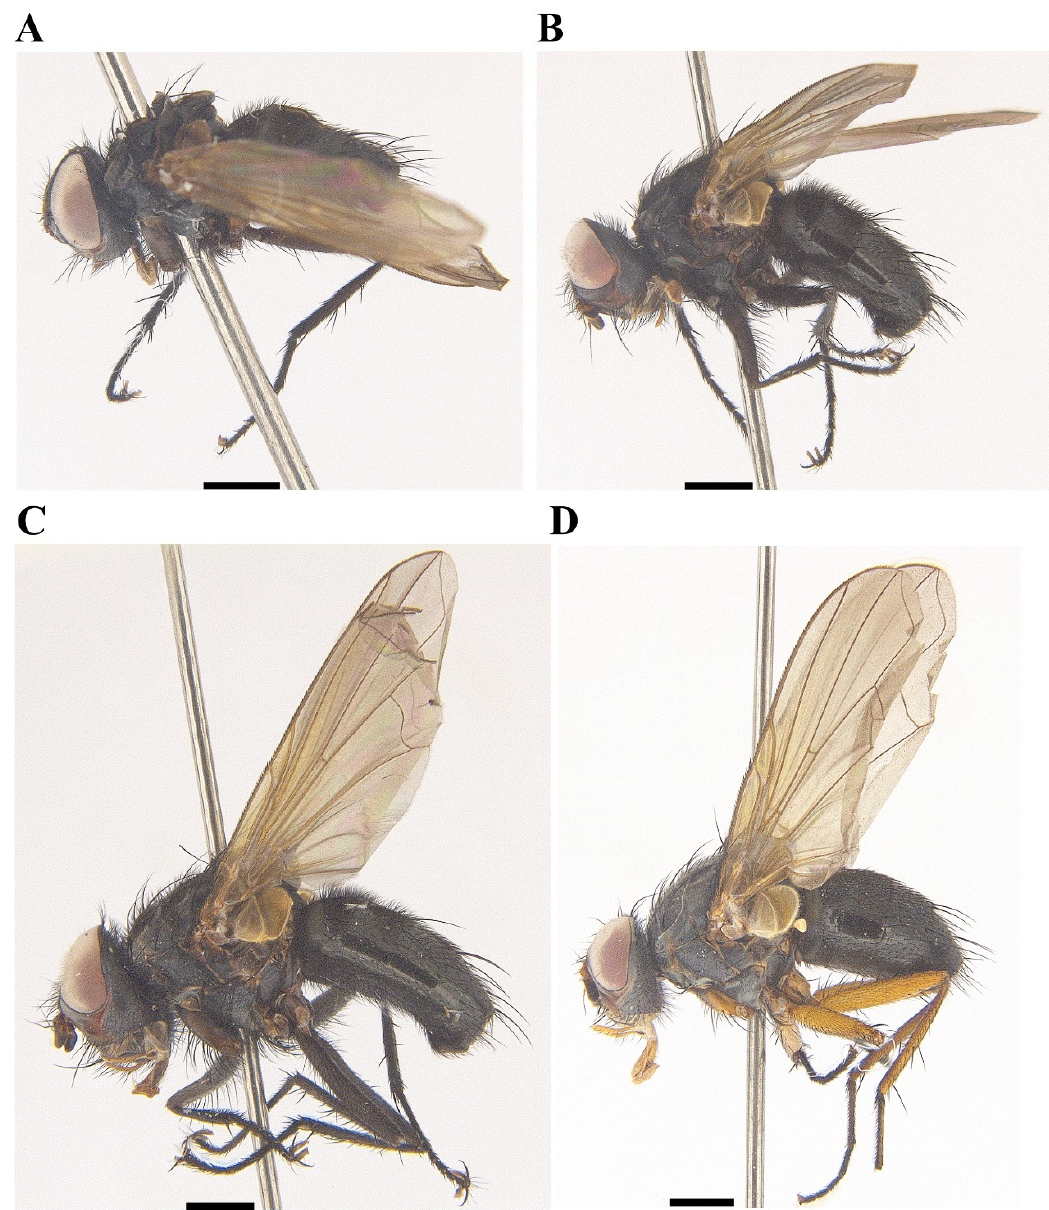
Figure 4. Lateral view of Macquartia spp., male habitus. ( A ) M. brunneisquama sp. nov. ( B ) M. chinensis sp. nov. ( C ) M. flavipedicel sp. nov. ( D ) M. flavifemorata sp. nov. Scale bar = 1 mm.